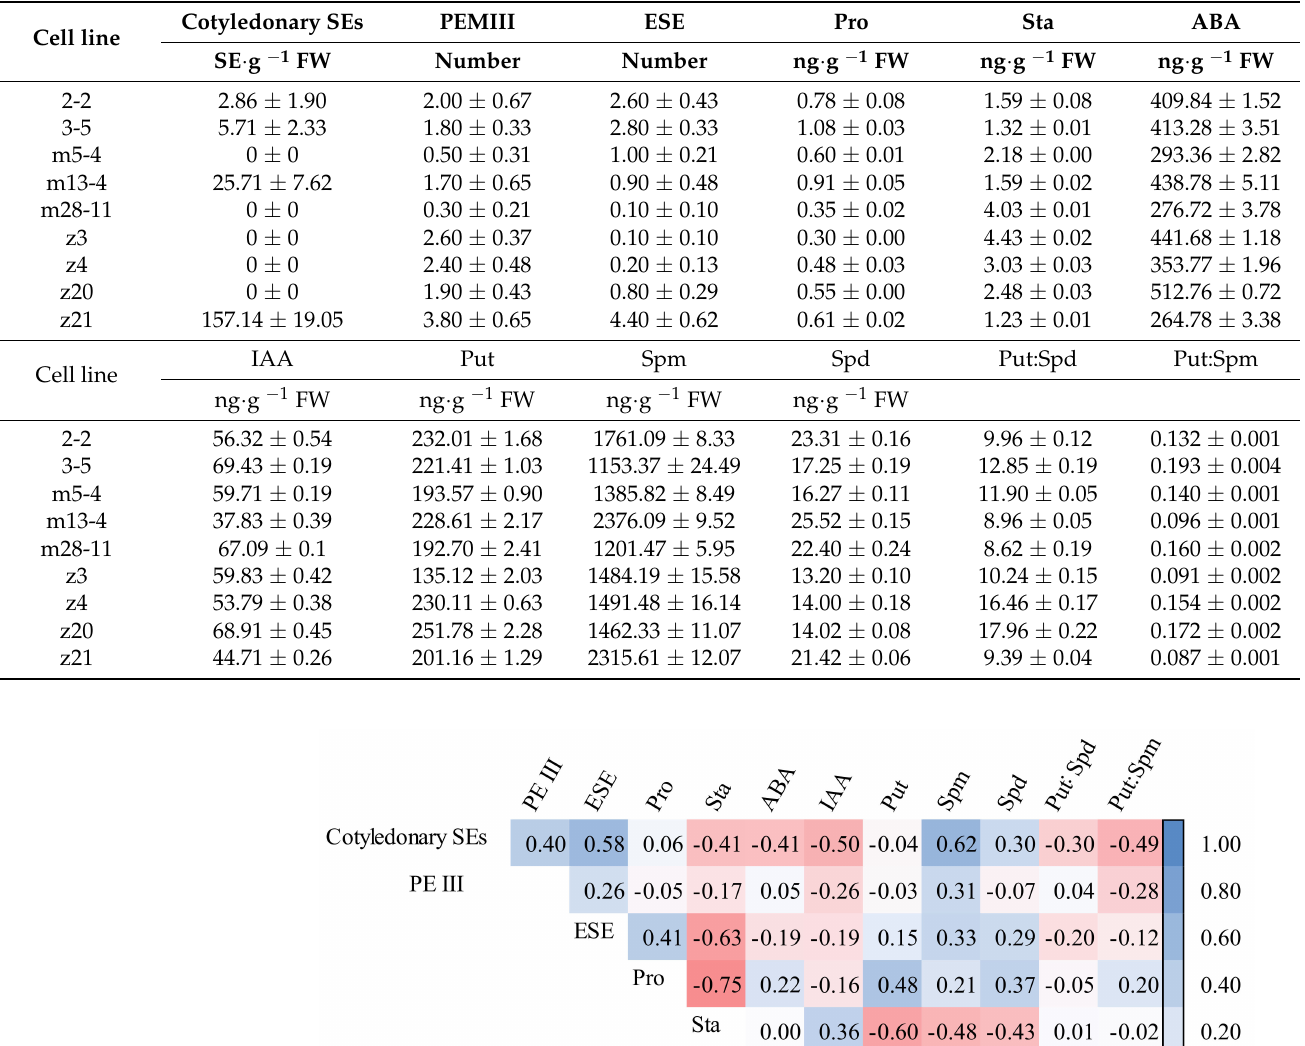
Table 1. Cotyledonary SE yield, PE III, ESE, soluble protein, starch, ABA, IAA, Put, Spm, and Spd content, and Put: Spd and Put: Spm differences between different cell lines of P. koraiensis .